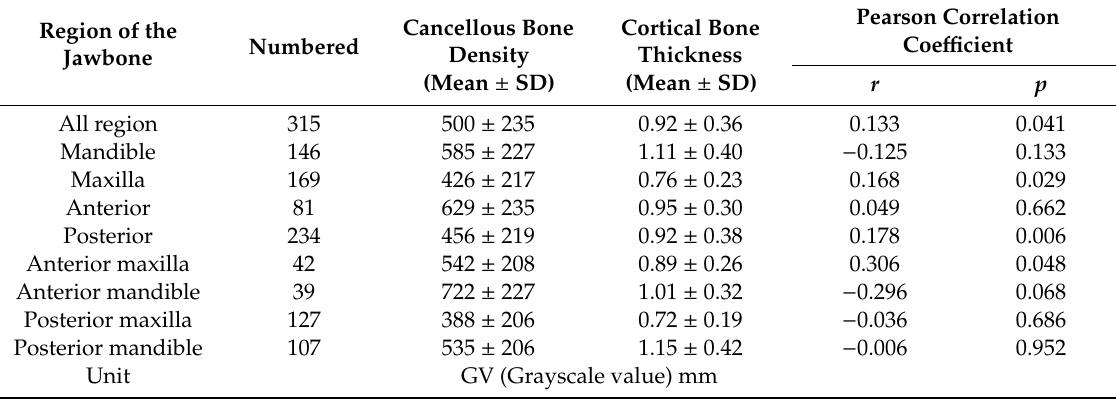
Table1. Relationshipbetweencancellousbonedensityandcorticalbonethicknessatdentalimplantsites. Table 1. Relationship between cancellous bone density and cortical bone thickness at dental implant sites. Region of the